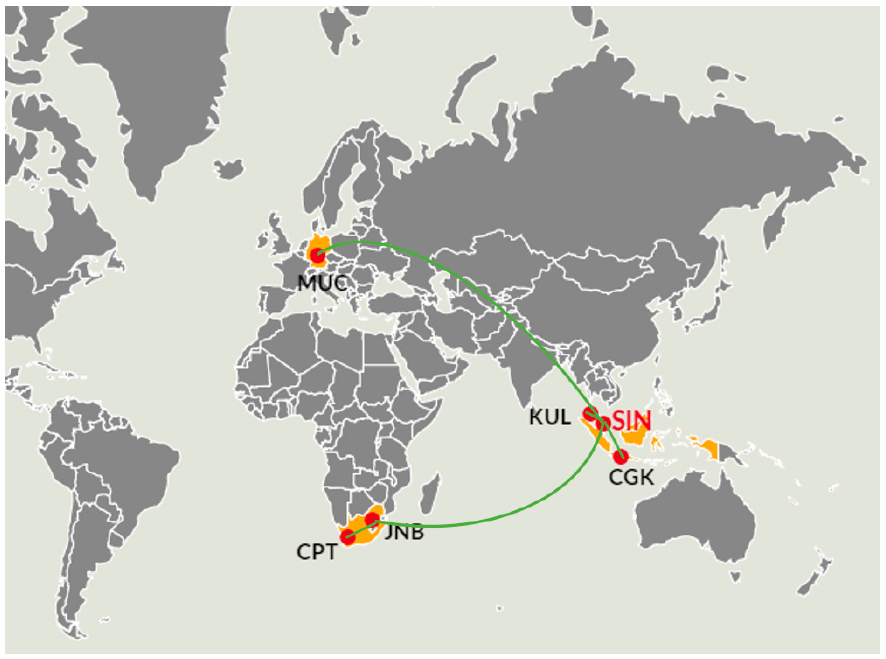
Figure 8. Air routes operated by Singapore Airlines Airbus A350-900 (Registration 9V-SME): 11–15 July 2018. Source: adapted from [143].